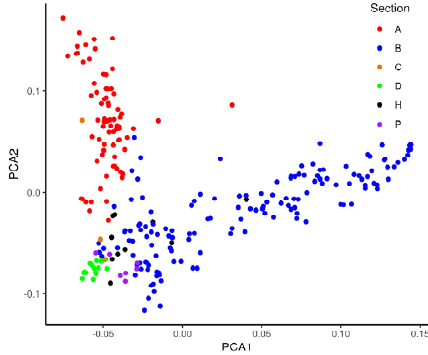
Figure 1. Principal components analysis for the Welsh ponies showing clustering between sections.